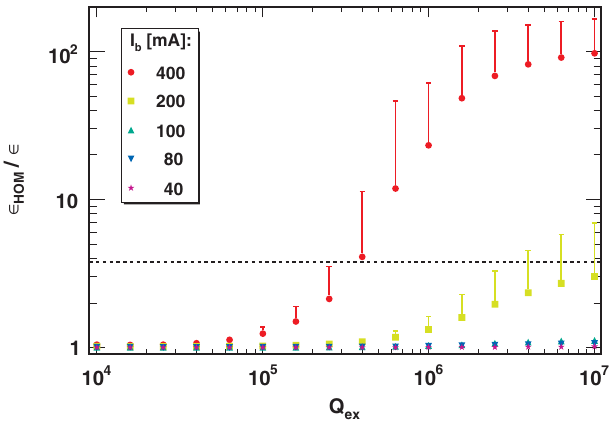
FIG. 21. Average longitudinal phase space increase and upper RMS error against the damping Q modes and different currents. Above the rf limit (dashed line) lossy runs occur. Settings: TM N ¼ 100 , see Table VI.